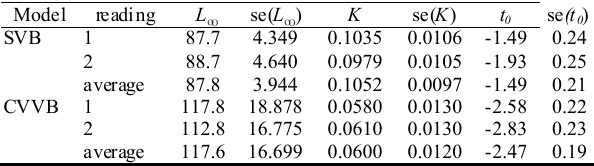
Fig. 8 . Von Bertalanffy growth curves for males and females fitted to length-at-age from sectioned otoliths using the constant variance assumption for the dog snapper Lutjanus jocu from Abrolhos Bank.